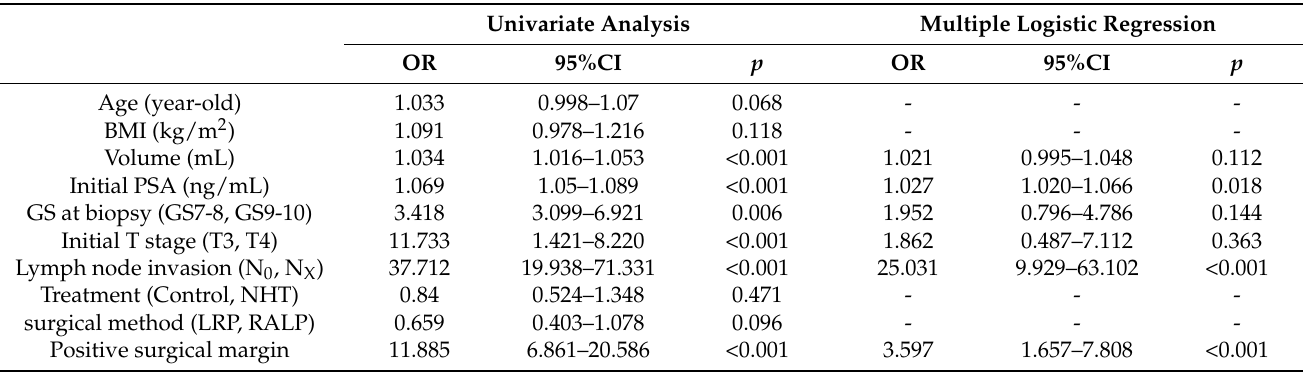
Table 6. Univariate and multiple logistic regression analysis of biochemical recurrence in the over- all